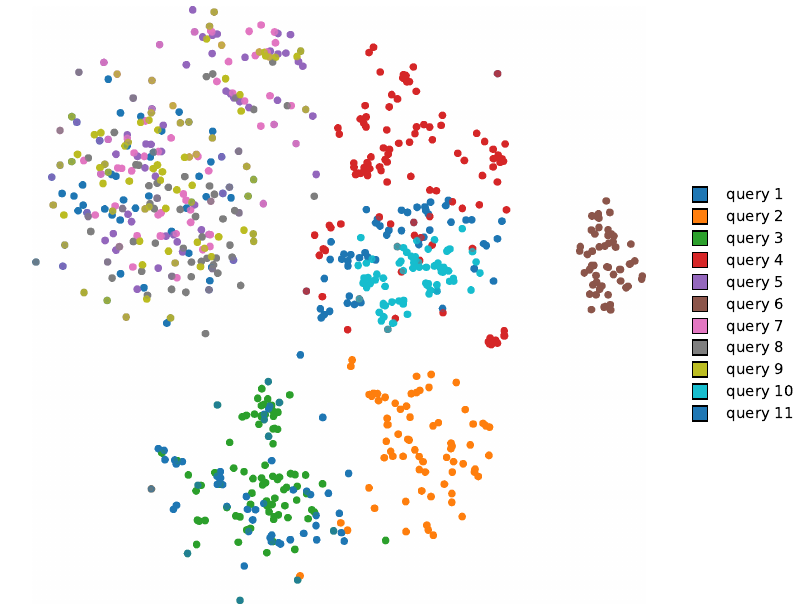
(cid:16) (cid:17) h r , r j .